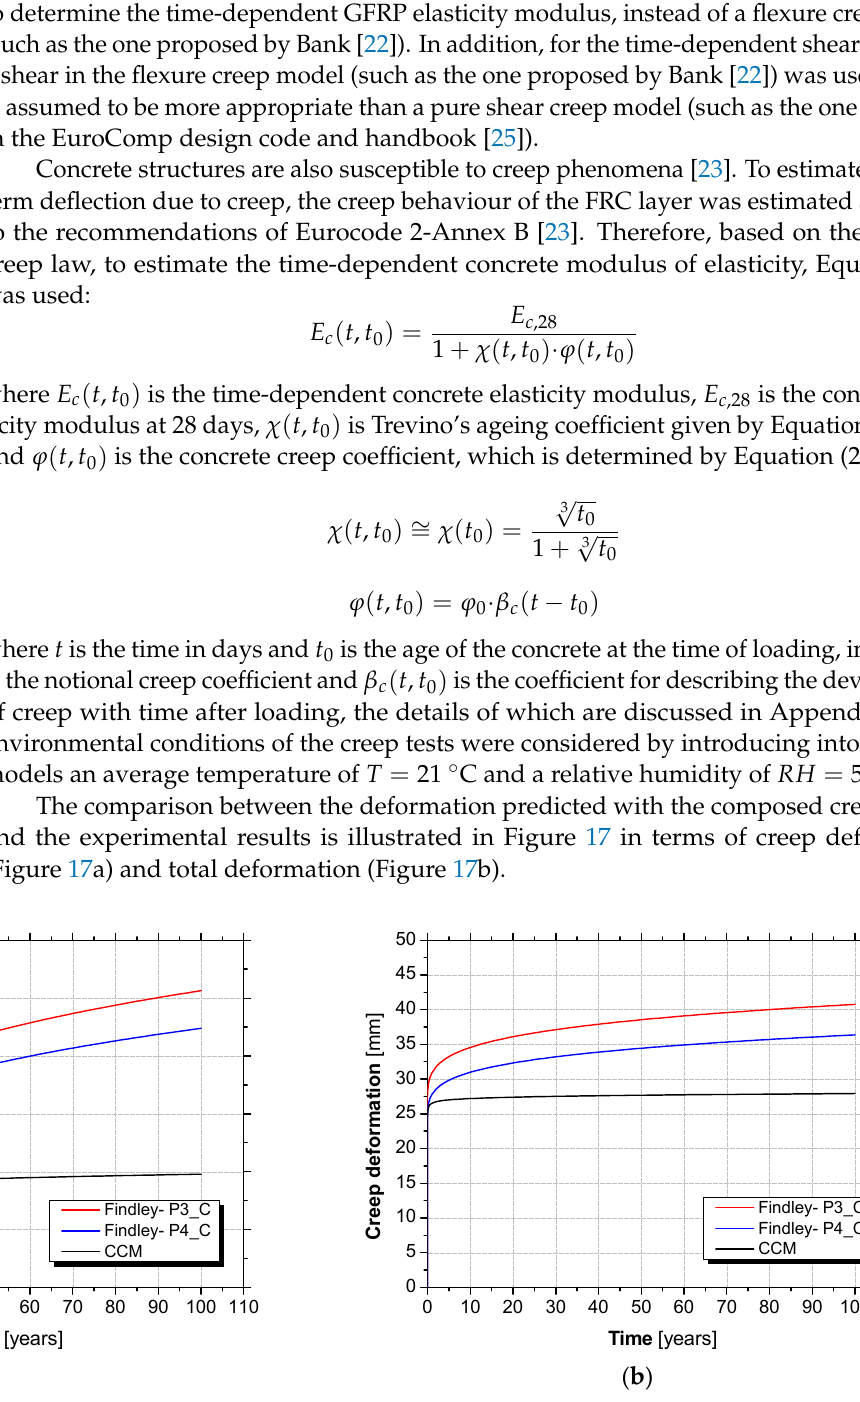
( b ) Figure 18. Long-term predictions of composed creep model versus Findley’s power law: ( a ) creep deformation and ( b ) total deformation. Table 14. Predictions of long-term creep deflections: composed creep model (CCM) and Findley’s power law. Specimen